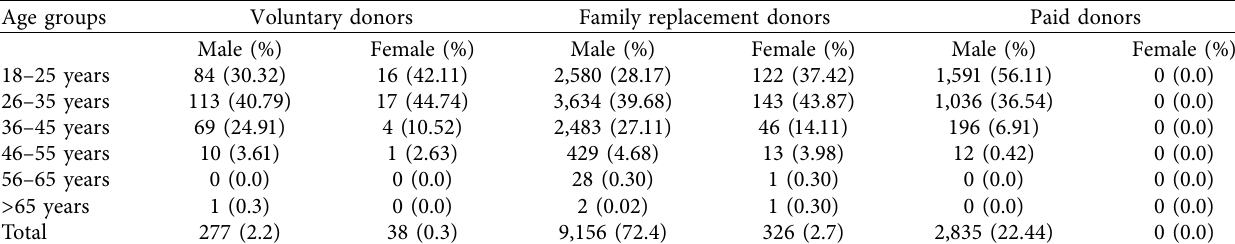
Table 2: Age and sex distribution of donors across the categories of blood donation.